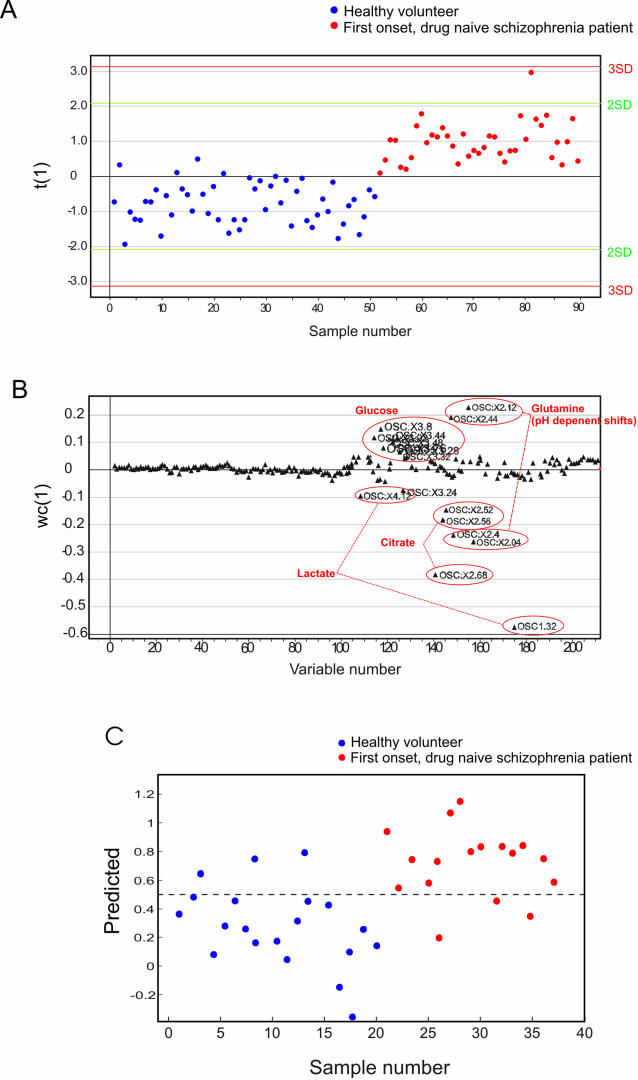
Validation and Prediction of Schizophrenia Group Membership Using a PLS ModelA PLS model was constructed using the OSC-filtered data from 37 drug-naïve patients with first-onset schizophrenia from the first cohort (red points) and 50 randomly selected healthy volunteers (blue points) (the “training set”). The scores plot (A) and the loadings plot (B) indicate the key resonances contributing to the separation: lactate, glucose, glutamine, and citrate. This model was then used to predict “group membership” (i.e., schizophrenia or control) in a test set of 17 drug-naïve patients (second cohort) with first-onset schizophrenia and the remaining 20 healthy volunteers which had not been used in the construction of the model. Predictions are made using a Y-predicted scatter plot with an a priori cut-off of 0.5 for class membership (C).